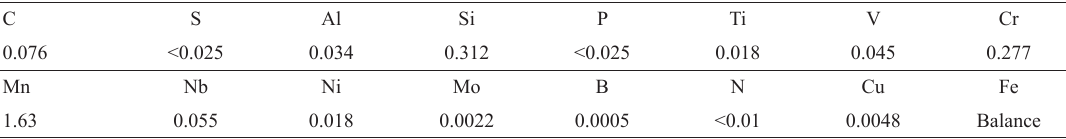
Table 1: Chemical composition of API 5L X70 (wt%).